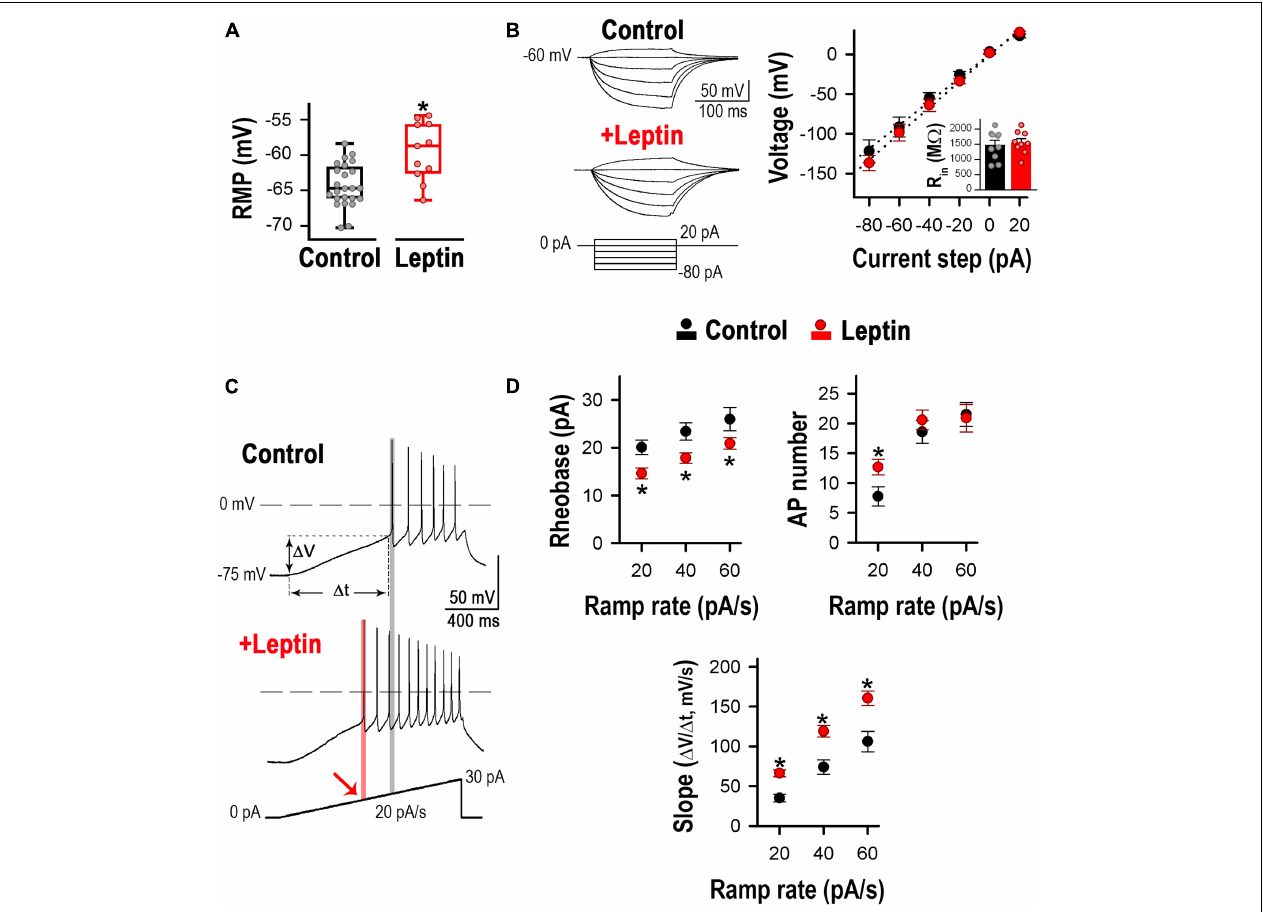
FIGURE 2 | Leptin increases excitability in cultured hypothalamic neurons. (A) Leptin application induced a ∼ 6 mV depolarization. Resting membrane potential (RMP) from control ( n = 24) and leptin-treated ( n = 11) neurons. *Significantly different from control, P < 0.05, t -test ( t = 3.923, df = 33). (B) Input resistance (R in ) from control ( n = 10) and leptin-treated neurons ( n = 9). Representative voltage traces (left) and average voltage-current (V-I) relation (right) in response to 200 ms current steps from –80 to 20 pA (every 20 pA, preset membrane potential = –60 mV). R in was calculated as the slope of the linear regression. No changes in R in were observed between control and leptin treatments ( P > 0.05, t -test, t = 0.3883, df = 17). (C) Examples of neuronal firing in control and leptin-treated neurons elicited from a preset membrane potential of –75 mV by a 20 pA/s ramp. The rheobase is indicated with the gray line in control and the pink line and arrow